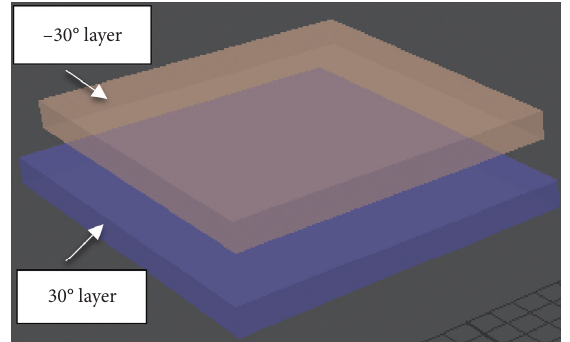
Figure 2: 2-Layered plate (30 ° / − 30 ° ).